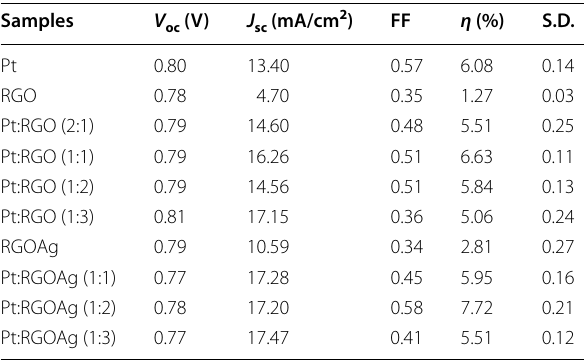
Table 2. The fill factor of DSSC with pure TiO 2 anode is